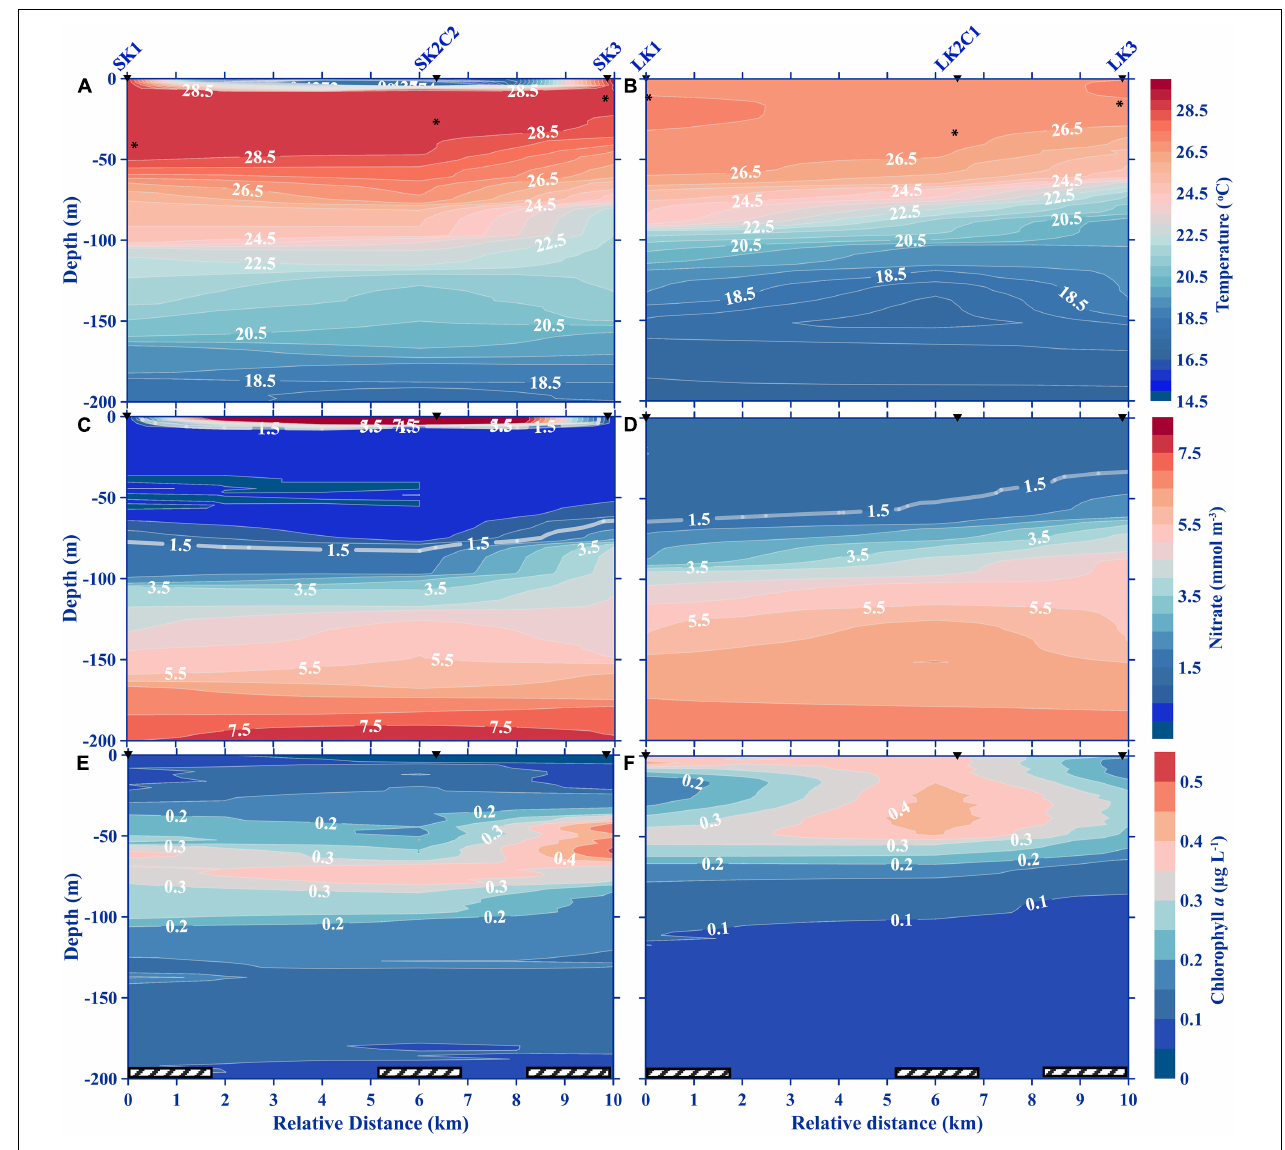
FIGURE 4 | Vertical profiles of temperature (A,B) , nitrate (C,D) , and Chl a (E,F) in the along-stream transect during small (2016) and large (2018) billow cases. The cast and station numbers denoted above the top graph apply to all panels in the column. Asterisks on the temperature panels denote the mixed layer depths. Hatched bars along the x -axis indicate nighttime